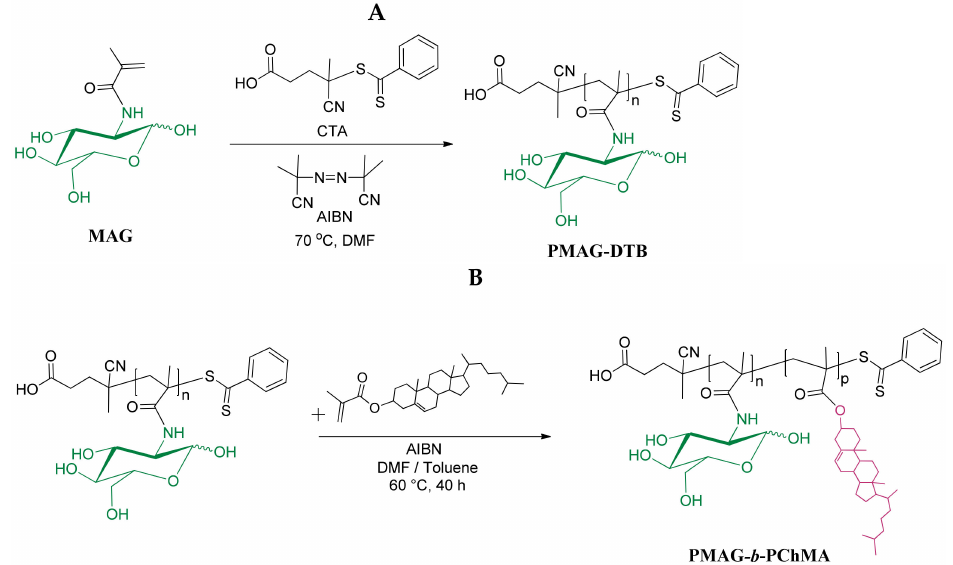
Figure 1. Schemes of PMAG ( A ) and PMAG- b -PChMA ( B )